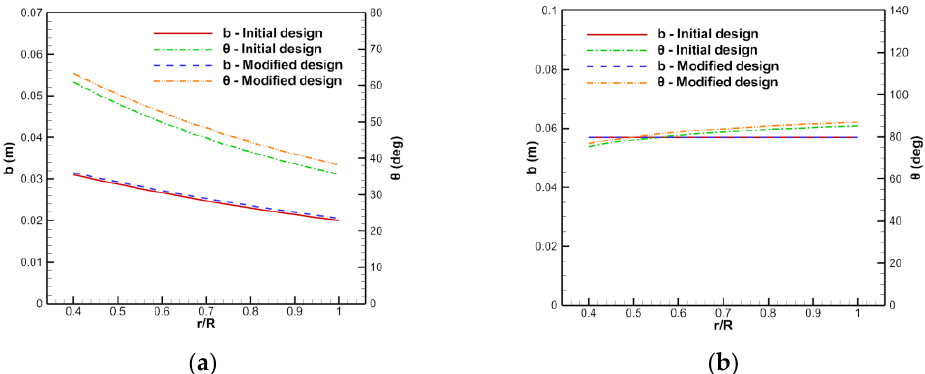
Figure 12. Comparison of the chord length and torsion angle of the blade before and after the modification: ( a ) Rotor, ( b ) stator.